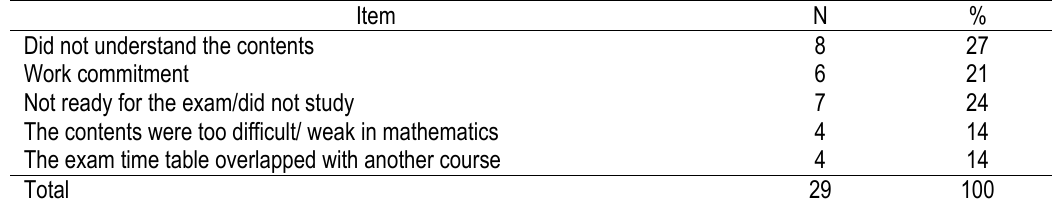
Table 3. Student’s Main Reasons for Not Attending the